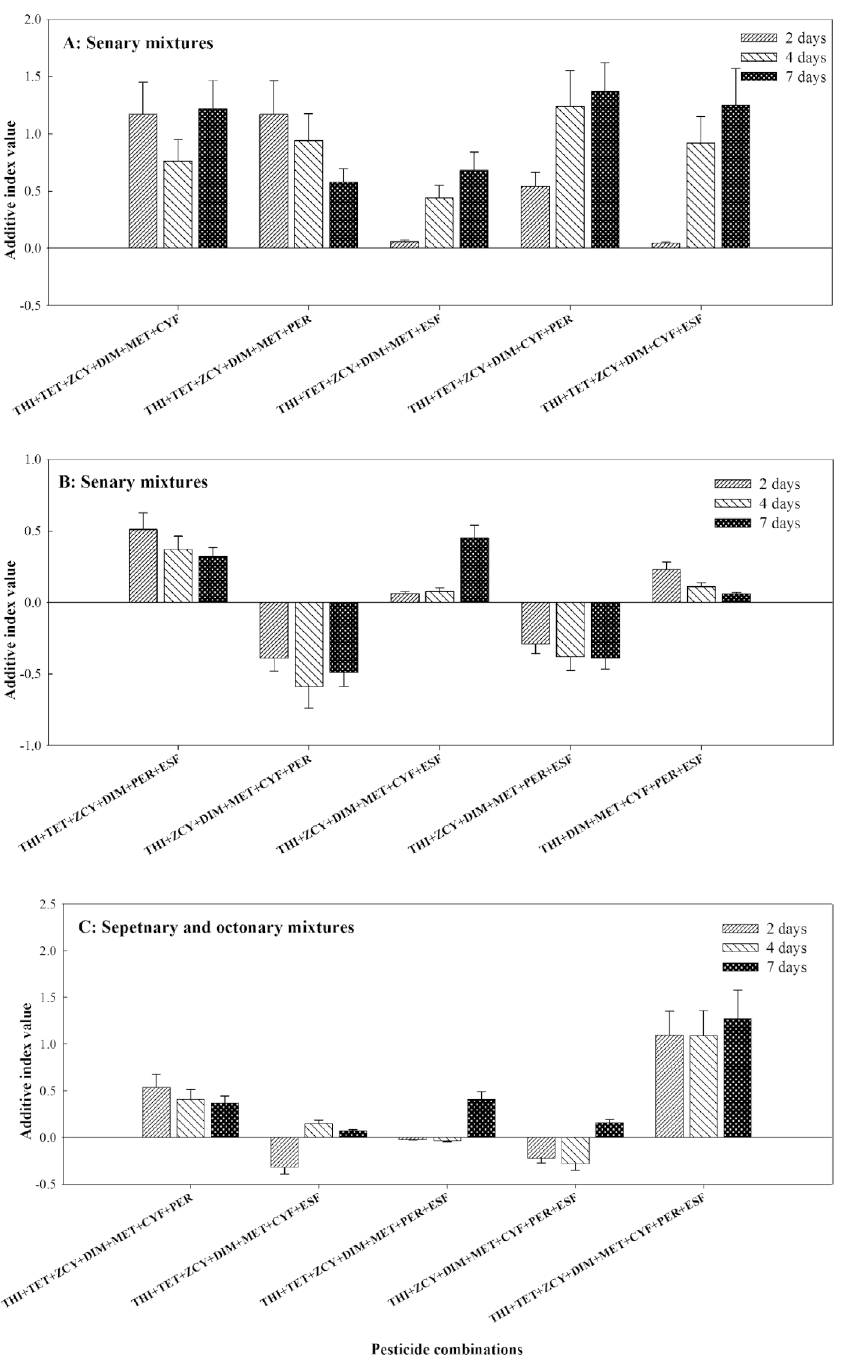
Figure 4. Joint toxic effects of senary combinations of thiamethoxam (THI) mixed with seven pesticides on honey bees. CI confidence interval, THI Thiamethoxam, TET Tetraconazole, ZCY Zeta -cypermethrin, DIM Dimethoate, MET Methomyl, CYF Cyfluthrin, PER Permethrin, ESF